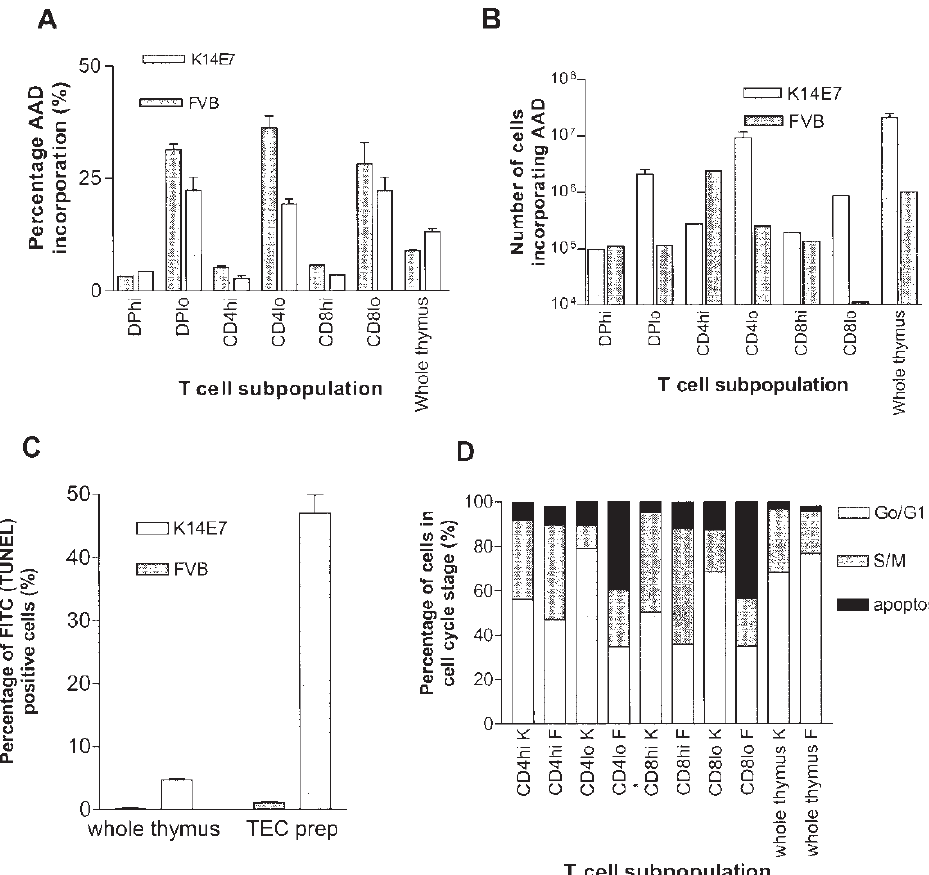
FIGURE 4 Apoptosis is increased in the K14E7 CD4 þ and CD8 þ thymic populations. (A and B) Thymic cell preparations from FVB and K14E7 mice were stained with biotinylated CD4/Streptavidin APC and CD8 FITC and then incubated in an AAD staining solution. The AAD staining of populations expressing different levels of CD4 and CD8 were compared to determine whether marker downregulation was reflected in a change in the level of apoptosis in the tg mice and is shown as (A) Percentage of AAD incorporation and (B) Absolute numbers of AAD positive cells. Cells were gated on CD4 and CD8 lo and CD8 hi populations as shown in Fig. 3 to provide estimates of apoptosis in the populations expressing different levels of these surface markers. (C) Single cell suspensions of K14E7 and FVB whole thymii or enriched TEC preparations were stained using a TUNEL assay to examine the contribution made by thymic epithelia to the overall level of apoptosis shown in whole thymus preparations. (D) Cell cycle status of different thymic subpopulations was compared between the K14E7 (K) and non-transgenic FVB (F) mice by staining thymic cell preparations using anti-CD4 and -CD8 surface marker antibodies followed by propridium iodide staining of nuclear DNA. All data shown are the mean results for four mice assayed separately. Three month old mice were used throughout.